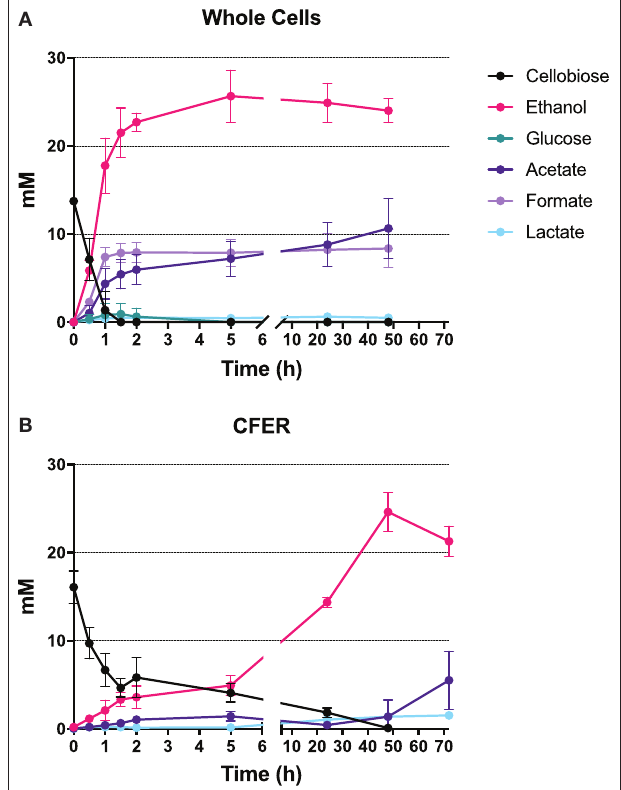
FIGURE 3 | Fermentation products from intact cells and CFER. (A) Cells were harvested from a 50-ml culture, then resuspended in 1mL of MTC-5 medium containing 15mM cellobiose as substrate and incubated at 55 ◦ C for 48h. (B) CFER was performed in a 1-ml volume by mixing CFE prepared from a 50-ml culture with CFE buffer, cofactors, and 15mM cellobiose. The CFER was incubated at 37 ◦ C under anaerobic conditions. Error bars represent 1 standard deviation calculated from six replicates. Raw data included in Supplementary Table 3